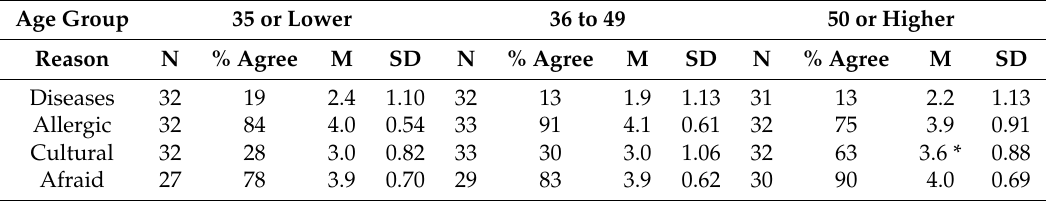
Table 2. Proportion of participants that agree / strongly agree and mean for reasons patients may not want to have a visit by a therapy dog in the ED: